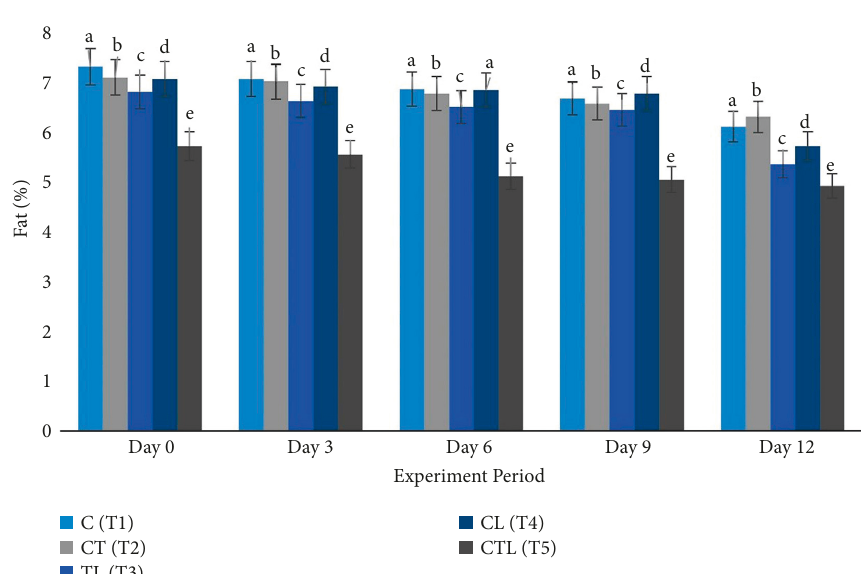
Figure 3: Percentage of fat content in the carp fillet immersed in mixed different extracts of turmeric, cinnamon, and lemon at 4 °